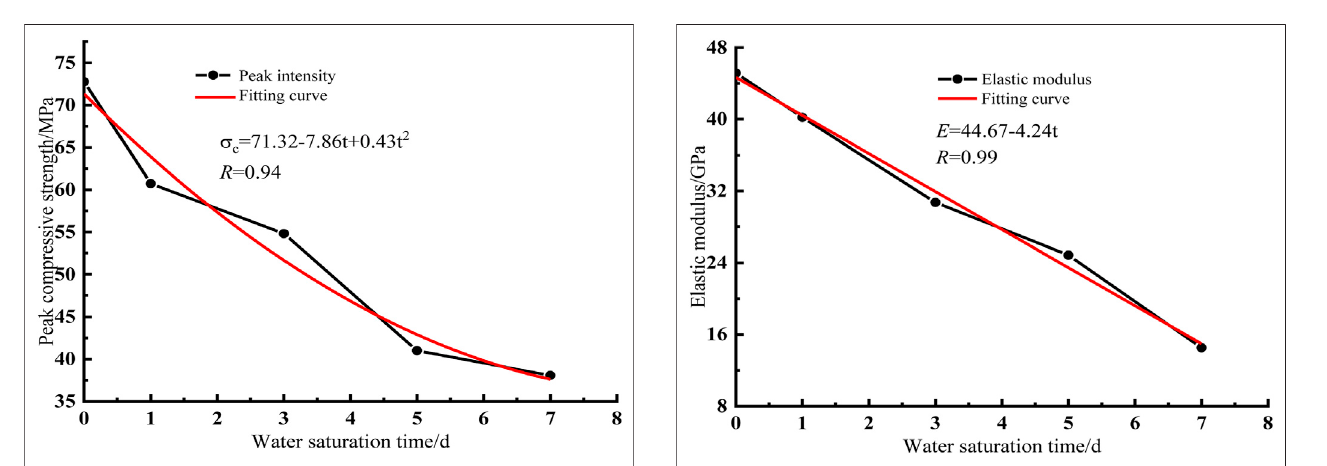
FIGURE 4 | Relationship between elastic modulus of jointed limestone and water saturation